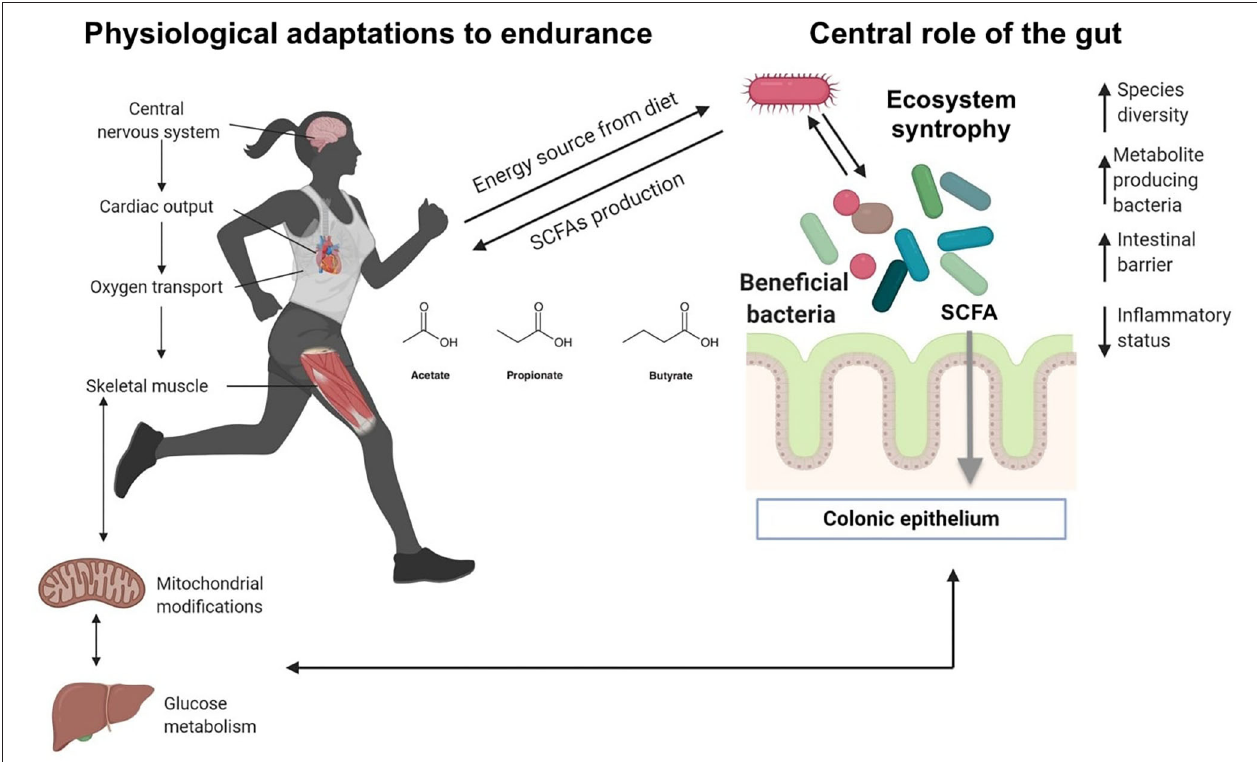
FIGURE 2 | Ecosystem level adaptation of gut microbiota in athletes. Recent research indicates that unique gut microbiota may be present in elite athletes, and special and unique species can positively impact the host, providing metabolites from the fermentation of dietary fiber. Ecosystem level syntrophy: gut bacterial species can hydrolyze fibers and subsequently ferment the sugar monomers into SCFA, while other fermentative species depend upon the hydrolytic ones. Such a syntrophy have been described between Bacteroides and Bifidobacterium strains. Modified from Aya et al. ( 40), with